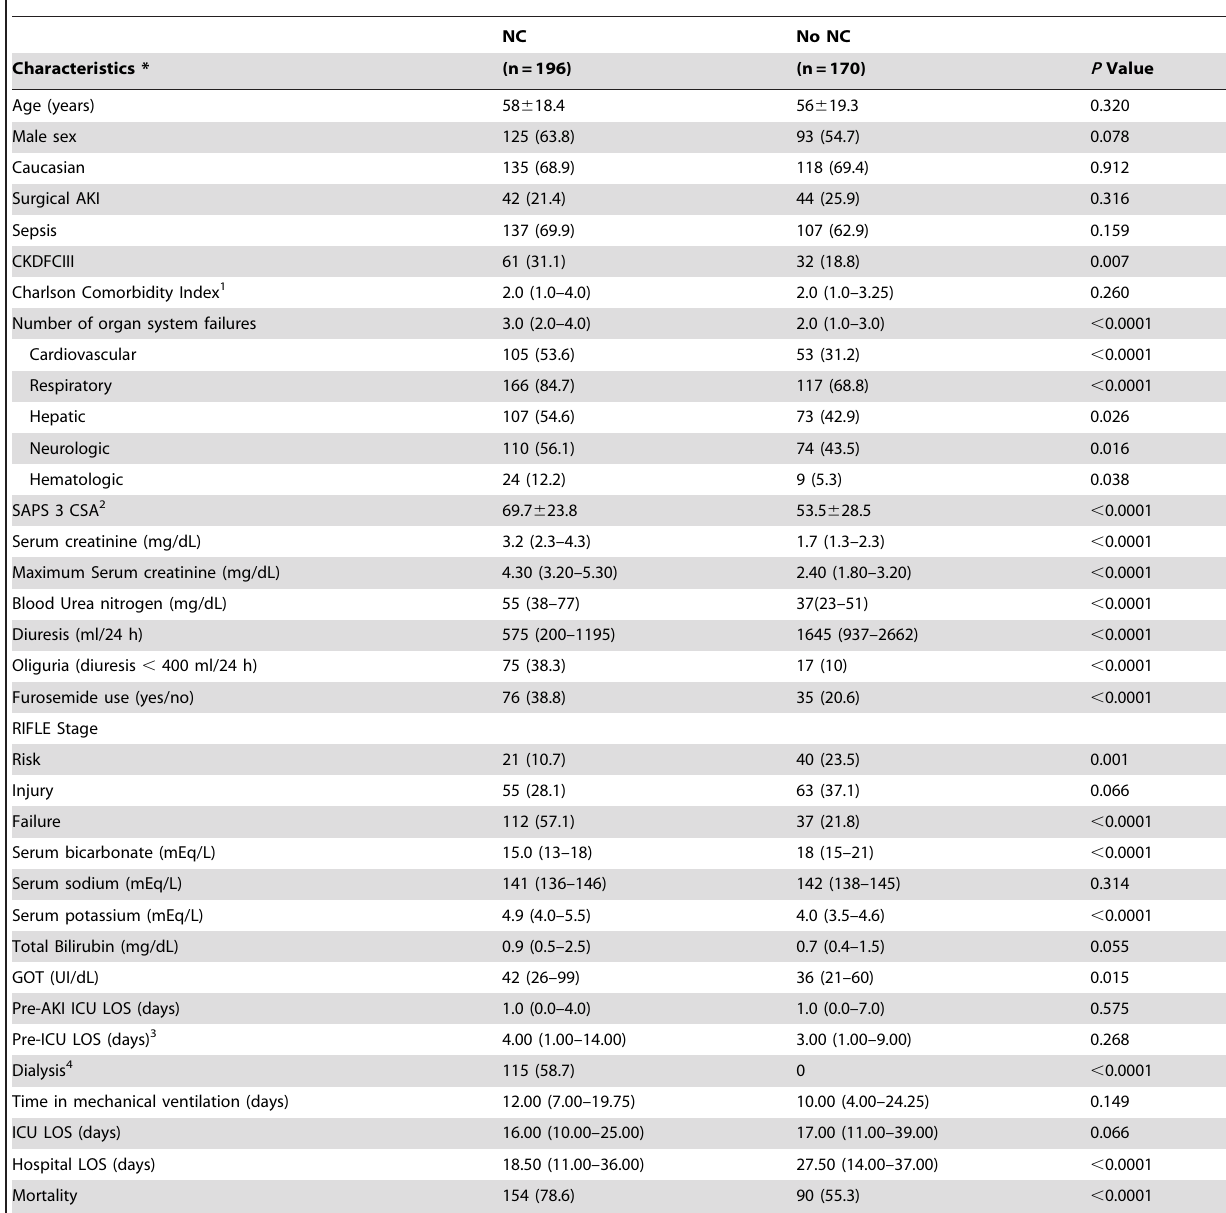
Table 1. Patients’ characteristics according to nephrology consultation